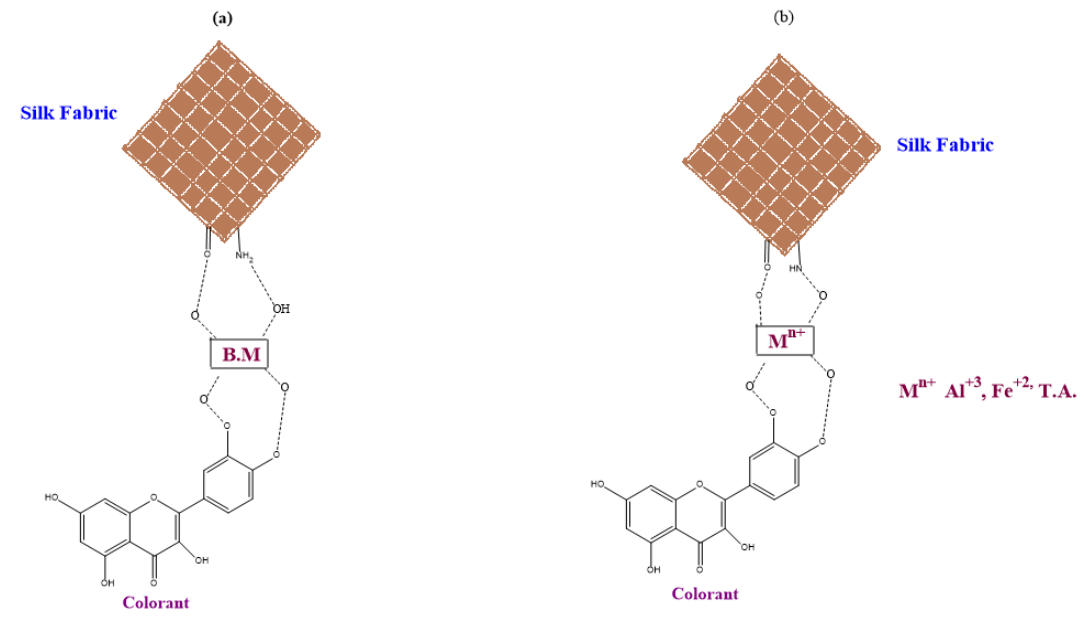
Figure 4. Proposed interaction of bio-mordant ( a ) and chemical anchor ( b ) with dye and silk fab- ric.